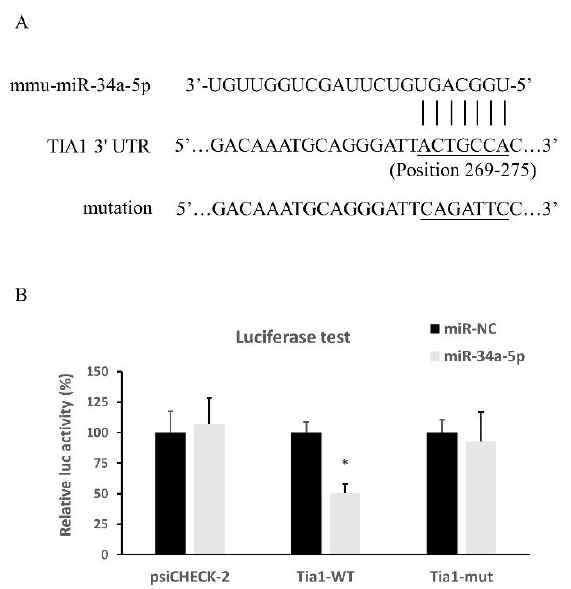
Figure 6. Direction interaction of miR-34a-5p with Tia1 examined by luciferase reporter assay. ( A ) Sequence alignment of putative miR-34a-5p binding sites in Tia1 3' UTRs, and the mutation sequences. ( B ) Activity of luciferase gene linked to the 3’ UTR of Tia1 mRNA. HEK293T cells were co-transfected with psiCHECK-2 constructed with 3′ UTR binding sites of miR-34a-5p and miR-34a-5p mimic or scrambled mimic control. Luciferase and renilla signals were measured 48 h after transfection. Data are expressed as mean ± SEM. * p < 0.05.